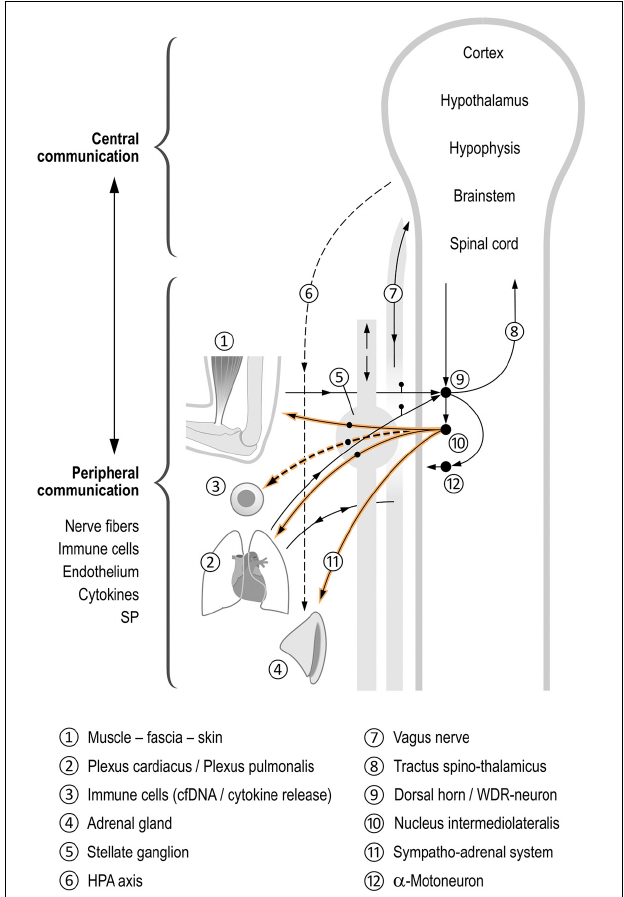
FIGURE 4 | Coordinating function of the autonomic nervous system (ANS) in the inflammatory process. This figure schematically shows the different control by sympathetic regulation of physiological processes following, for example, muscular overload of the upper extremity (cid:192) . Spinal reflexes cause an activation of the stellate ganglion activity (cid:196) , but also activate different neuronal and non-neuronal feedback loops at different levels, namely the peripheral–spinal, brainstem, and brain, all being interdependent (Jänig, 2006; Janig, 2014; Fischer et al., 2021), see Figure balls 6–12. They coordinate the musculoskeletal system, internal organs, and immune and inflammatory systems (balls 1–4). The nervous system–immune system communication is obvious and occurs in both the peripheral and central parts of the ANS (Elenkov et al., 2000; Bellinger and Lorton, 2014; Janig, 2014).